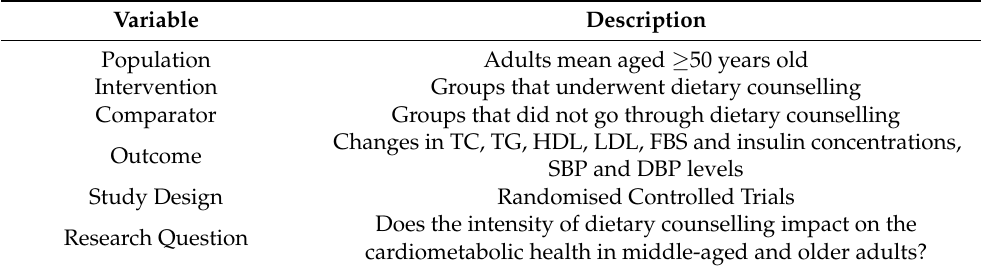
Table 1. PICOS criteria for the inclusion of studies.